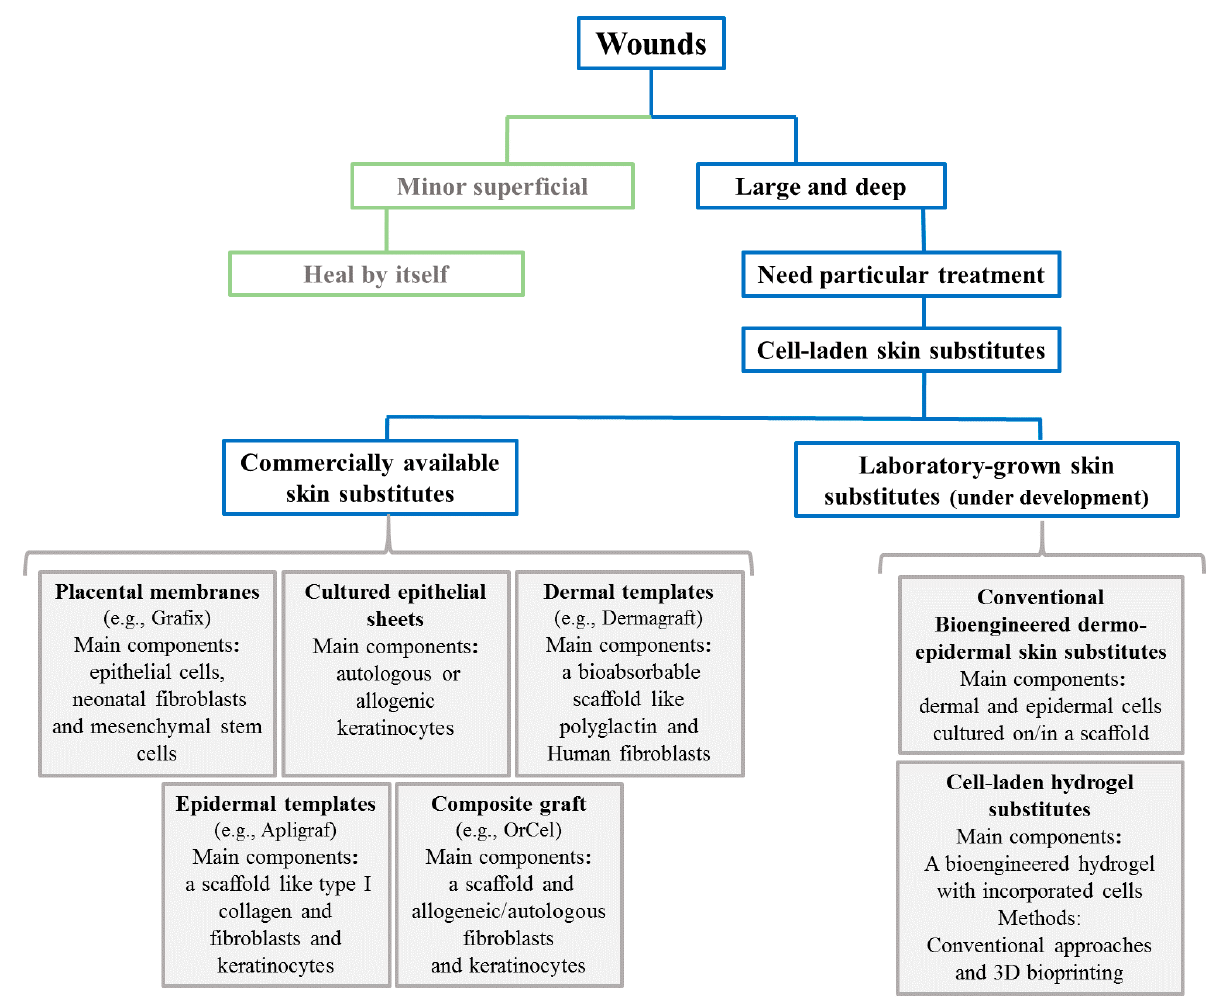
Figure 1. A schematic classification and summary of different commercial and bioengineered skin substitutes for large and hard-to-heal wounds.